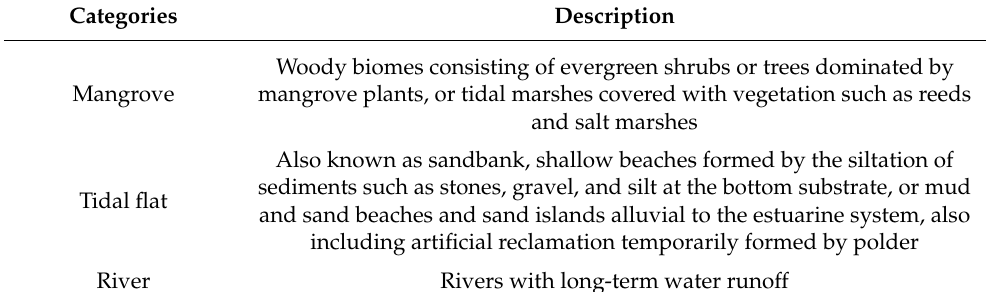
Table 2. Description of the land use and cover classification system used in this study.